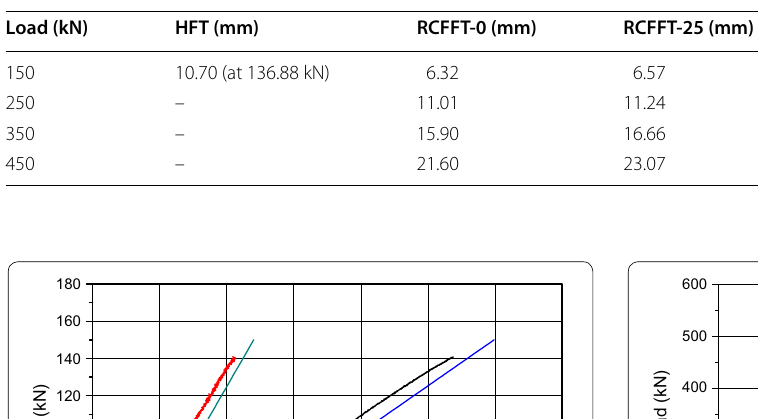
Table 3 Load–deflection results.